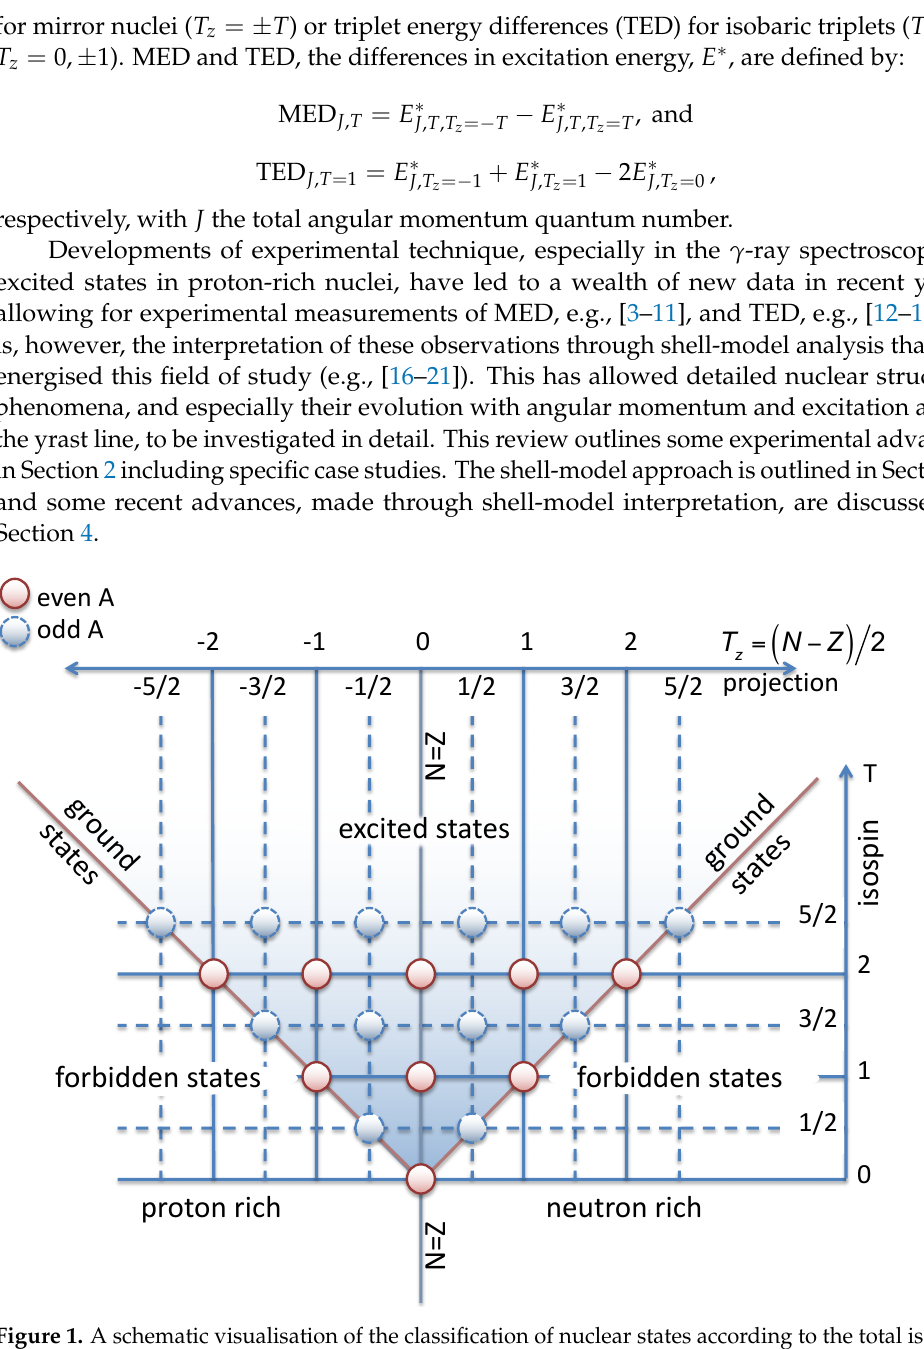
Figure 1. A schematic visualisation of the classification of nuclear states according to the total isospin quantum numbers T , T z . Each circle represents a set of states, of given isospin, which are allowed by the Pauli principle. Note that the diagram assumes that the lowest-energy set of states in any nucleus have the lowest allowed value of isospin. This is usually, but not always, true, e.g., odd-odd N = Z nuclei (equal and odd numbers of neutrons, N , and protons, Z